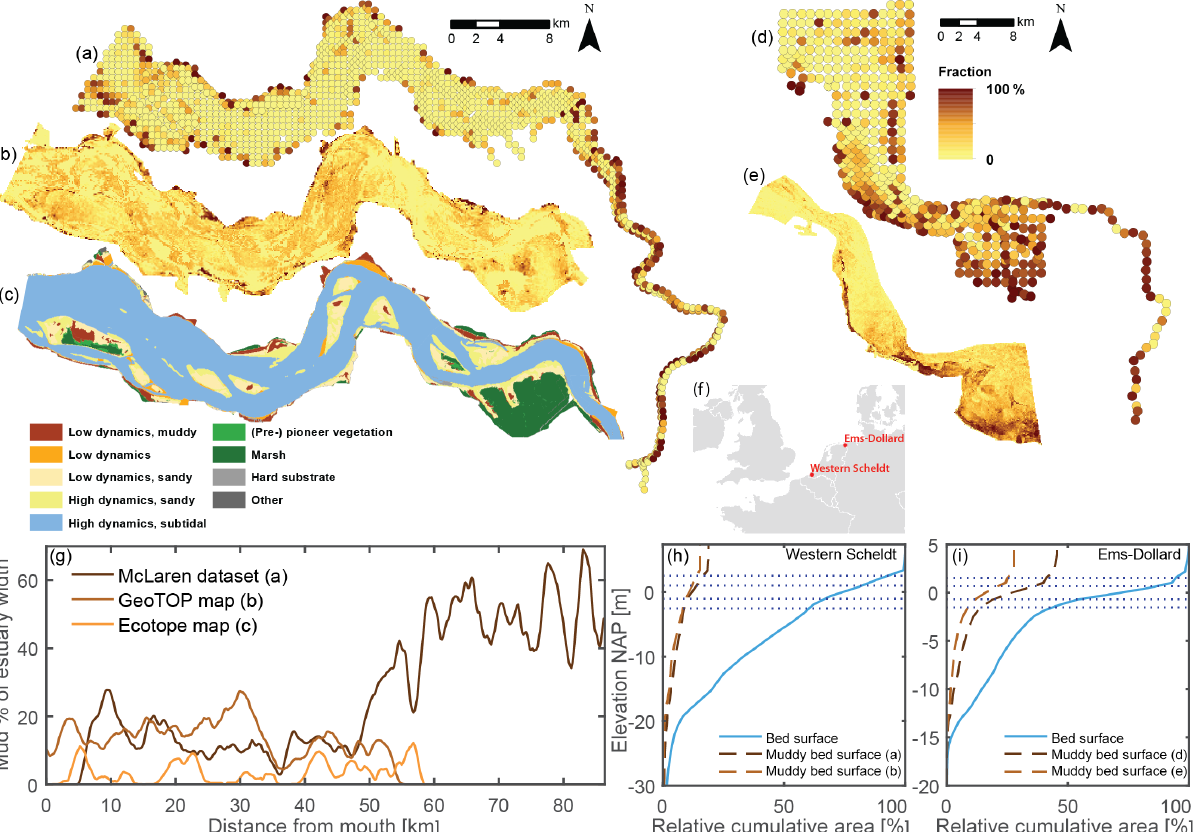
Figure 1. Mud in the bed of the Western Scheldt and the Ems-Dollard. (a) Percentage of mud in the top 10cm of the bed (McLaren, 1993, 1994), (b) GeoTOP map (v1.3) of probability of clay in the top 50cm of the bed (TNO, 2016) and (c) an indicative morphodynamics map of the Western Scheldt (Rijkswaterstaat, 2012). (d) Fraction of mud in the top 10cm of the bed (Van Heuvel, 1991; Rijkswaterstaat, 2009) and (e) GeoTOP map (v1.3) of probability of clay occurrence in the top 50cm of the bed (TNO, 2016). (f) Surface mud distribution along the Western Scheldt from the three datasets. For the ecotope data only the low dynamics muddy class was used. ( g – h ) Cumulative and normalised hypsometric curves of surface area related to bed elevation. Plot includes the (cumulative and normalised) distribution of mud relative to the total area with reference to figure panels for the mud datasets. Dotted lines indicate high and low water levels during spring and neap tide at the